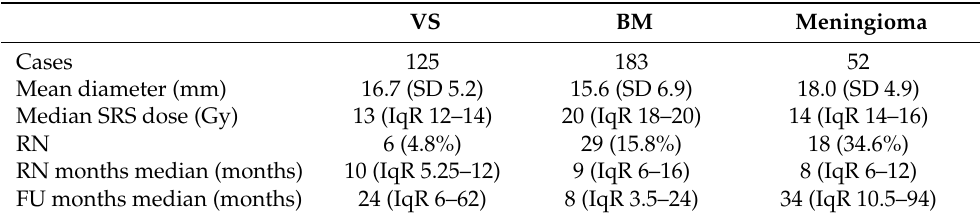
Table 2. Incidence of RN as well as diameter, SRS dose and FU between different tumor types. VS vestibular schwannoma, BM brain